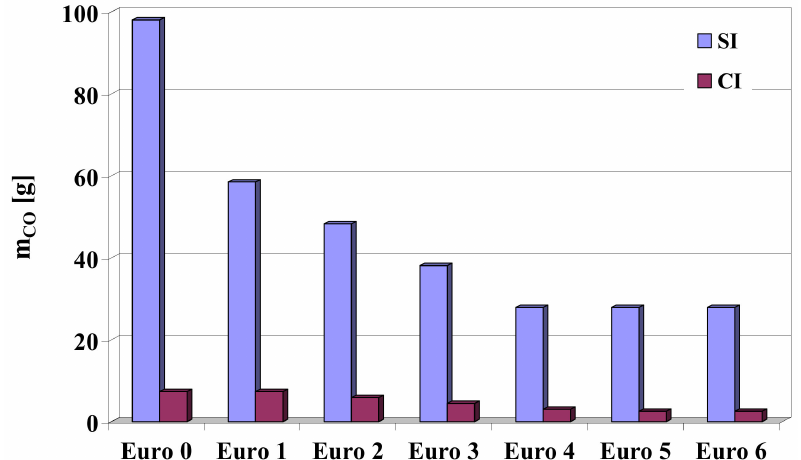
Figure 7. Additional carbon monoxide emission—m CO , during warm-up of the spark-ignition engine—SI or the compression-ignition engine—CI of passenger cars of Euro 0–Euro 6 pollutant emission categories, under the model conditions for vehicle traffic.